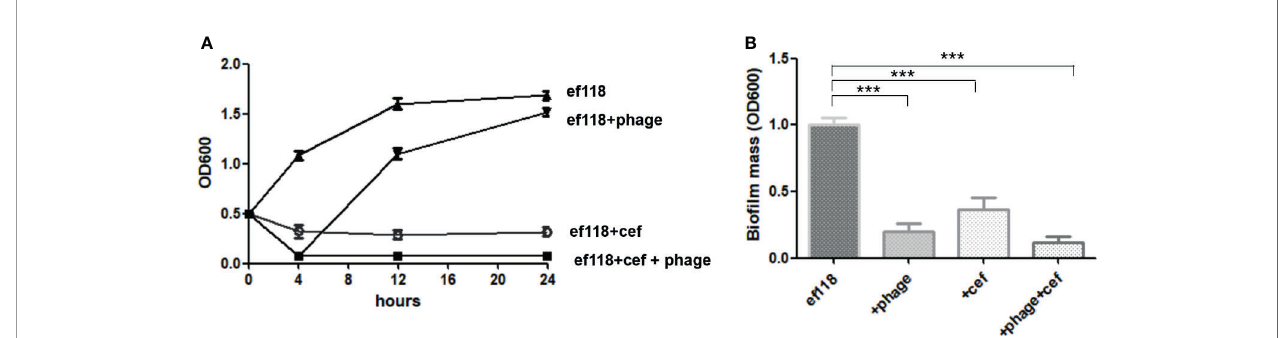
FIGURE 4 | Phage-antibiotic synergism. (A) Phage could only inhibit the growth of E. faecalis for several hours, and then the phage resistance mutant grows to a high density. (B) The phage-antibiotic combination has better ef fi cacy in destroying the bio fi lm than phage or antibiotic alone (*** P <